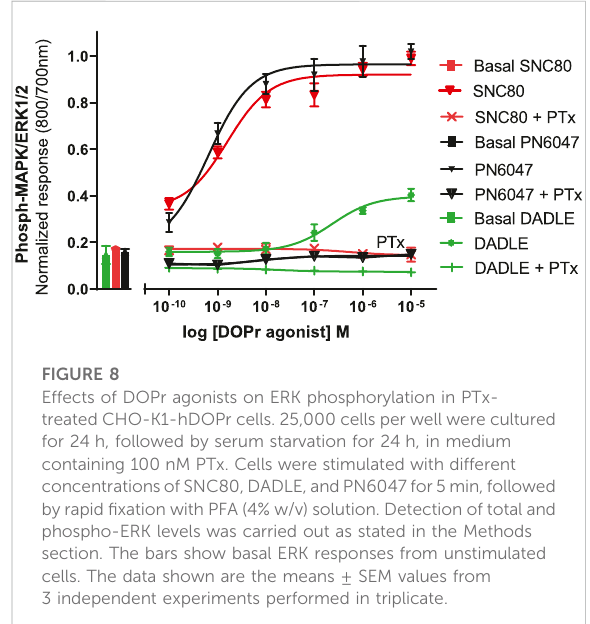
FIGURE 8 Effects of DOPr agonists on ERK phosphorylation in PTx- treated CHO-K1-hDOPr cells. 25,000 cells per well were cultured for 24 h, followed by serum starvation for 24 h, in medium containing 100 nM PTx. Cells were stimulated with different concentrationsofSNC80,DADLE,andPN6047for5min,followed by rapid fi xation with PFA (4% w/v) solution. Detection of total and phospho-ERK levels was carried out as stated in the Methods section. The bars show basal ERK responses from unstimulated cells. The data shown are the means ± SEM values from 3 independent experiments performed in triplicate.